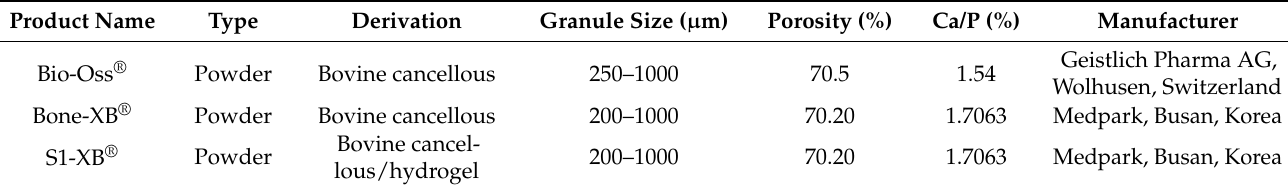
Table 1. Characteristics of bone graft